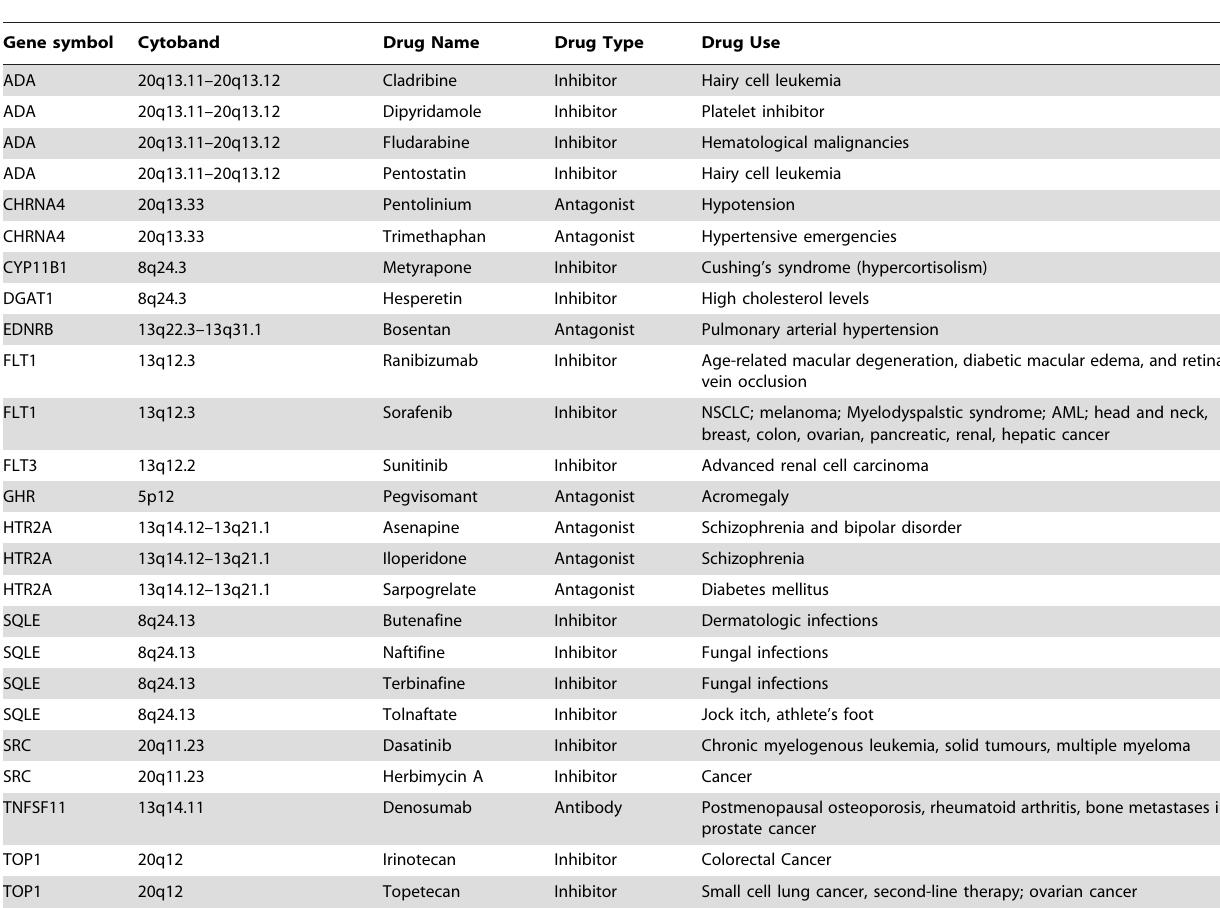
Table 5. Approved antibody, antagonist, inhibitor drugs targeted against genes in amplified regions in CRC.